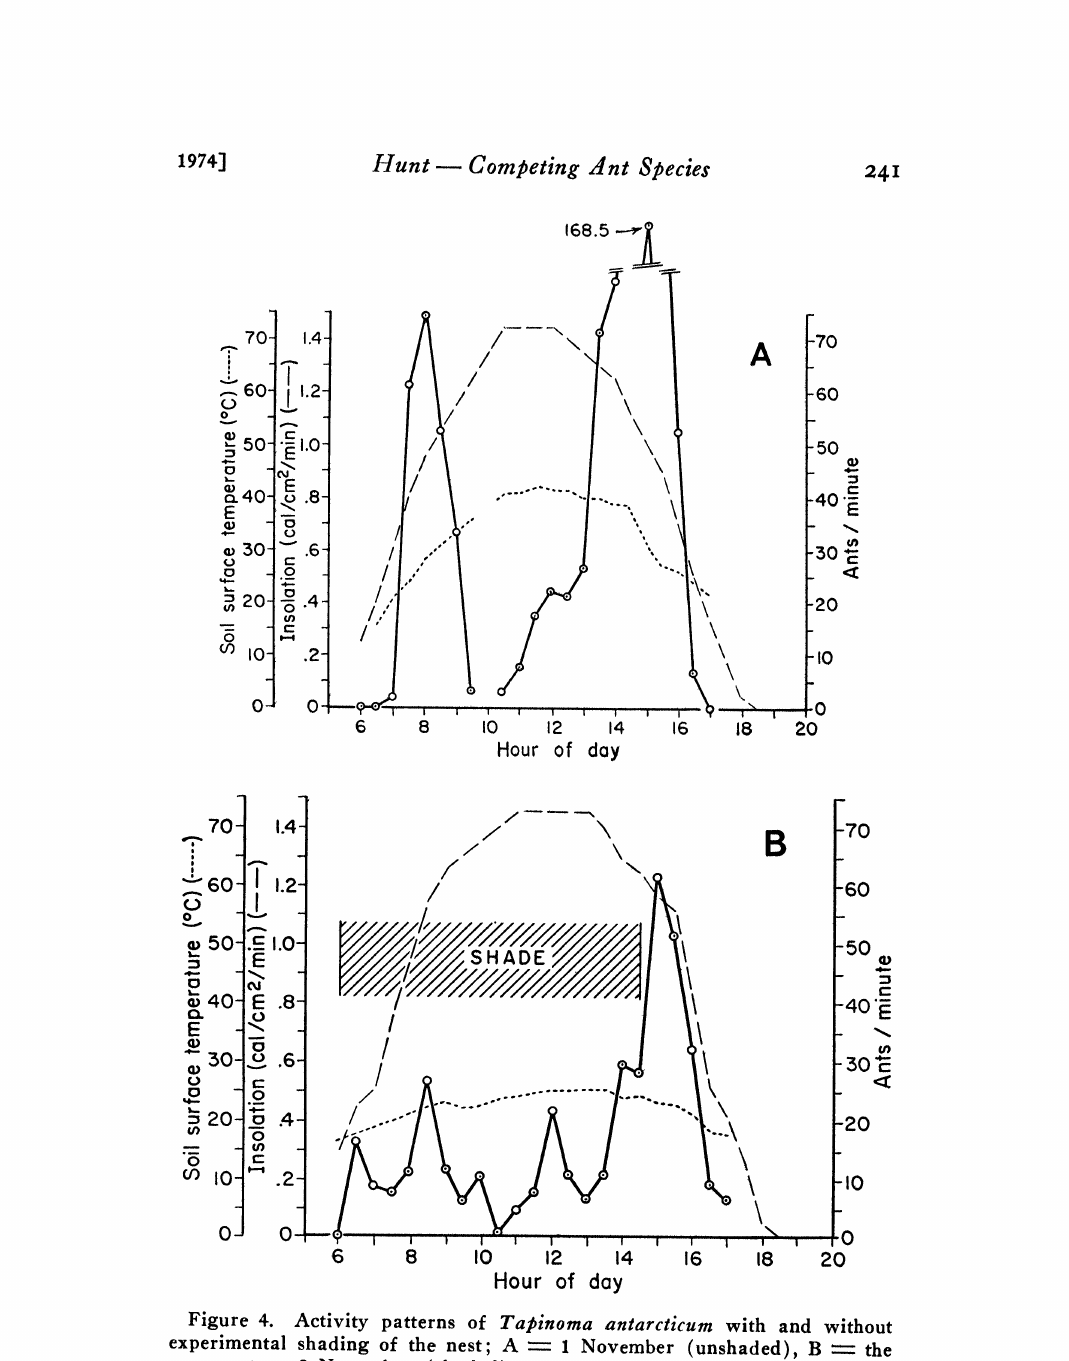
Figure 4. Activity patterns of Tatinoma antarcticum with and without experimental shading of the nest; A-- November (unshaded), B the same nest on 2 November